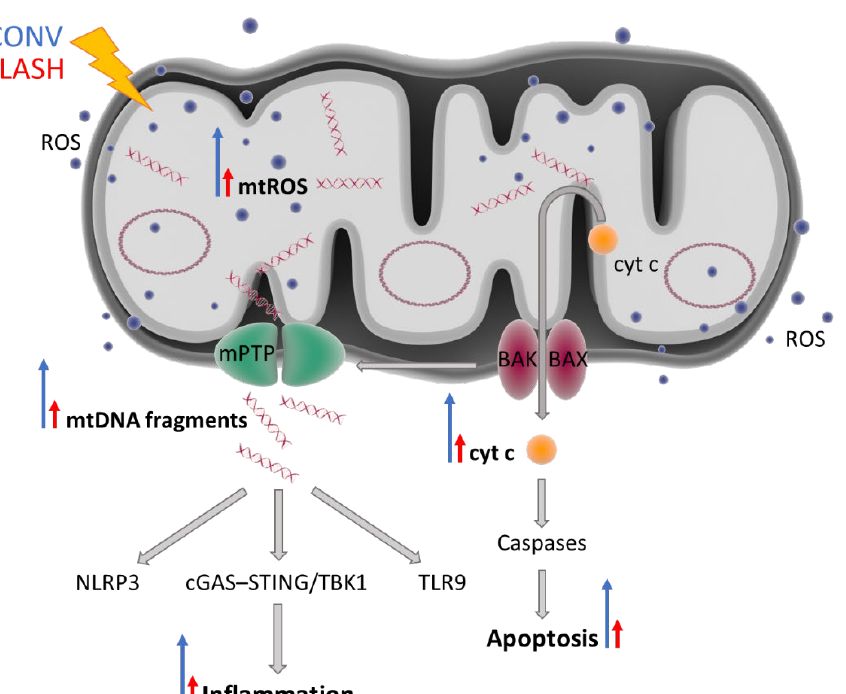
Figure 2. FLASH irradiation might induce minimal mitochondrial damage, resulting in less inflam- mation and less apoptosis compared to CONV RT. Radiation can damage mtDNA either by directly interacting with it or indirectly via ROS generated as the result of water radiolysis. Dysfunctional mitochondria produce increased levels of endogenous ROS. Mitochondrial dysfunction and overall cellular stress result in activation of pro-apoptotic BAK and BAX proteins, which form pores in the mitochondrial outer membrane and promote the release of cytochrome c into the cytoplasm, thus initiating a cascade of apoptotic events. BAK and BAX also induce mitochondrial outer membrane permeabilization (MOMP) and are required for the opening of the mitochondrial permeability transition pore. MOMP enables the release of damage-associated molecular patterns such as fragmented or oxidized mtDNA, which can trigger inflammation via the activation of three main pro-inflammatory pathways: NLRP3, cGAS–STING/TBK1, and TLR9. The blue long arrows indicate a great induction (CONV) and the red short arrows indicate a decreased induction (FLASH). The blue dots and oval circles represent ROS and circular mtDNA, respectively. Abbreviations: BAK, Bcl2 homologous antagonist/killer; BAX, BCL-associated X; cGAS–STING, GMP/AMP synthase–stimulator of interferon genes DNA-sensing system; cyt c, cytochrome c; mPTP, mitochondrial permeability transition pore; mtDNA, mitochondrial DNA; NLRP3, nucleotide-binding oligomerization domain-like receptor family pyrin domain containing 3; ROS, reactive oxygen species; TLR9, toll-like receptor 9; TBK1, TRAF family-member-associated NF- κ B activator-binding kinase 1.